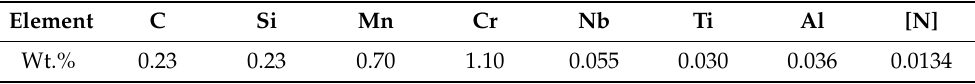
Table 1. Chemical composition of the investigated steels (Main alloying elements).